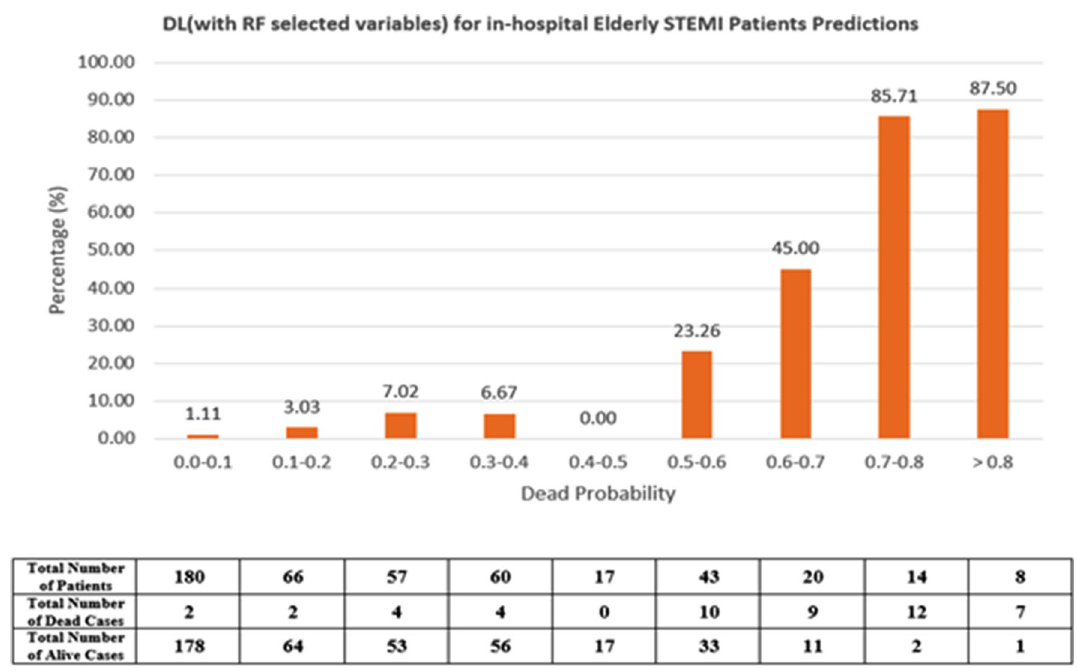
Figure 3. Mortality rate distribution on the validation set of DL (using RF variables) model.